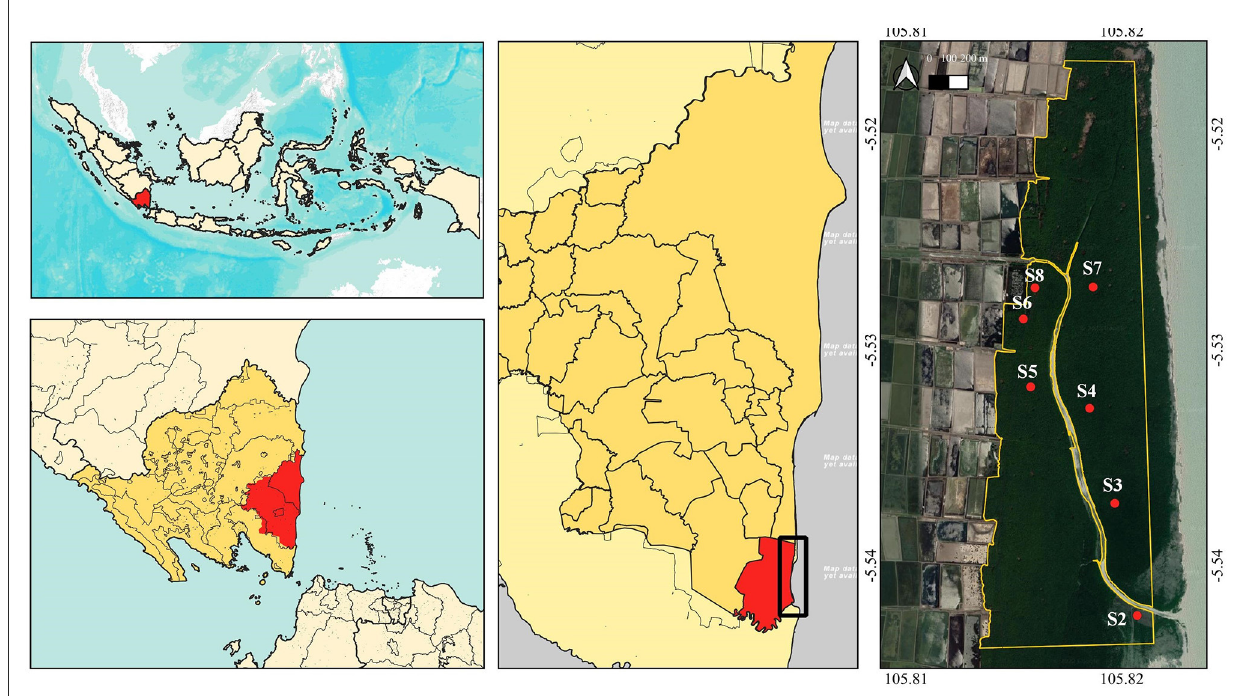
FIGURE1 Map of the research location in East Lampung, Sumatra, Indonesia, research area, and research stations coordinate referred to Marpaung (2021) (map base: ESRI Terrain, Google Satellite on QGIS 3.24, accessed on 25 December 2022).